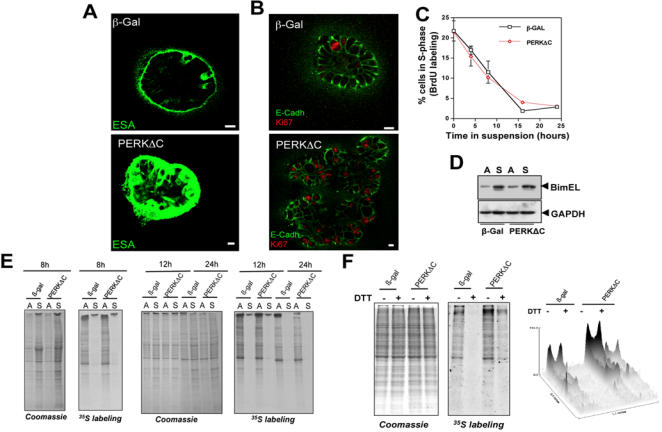
Immunofluorescence for ESA and E-cadherin In β-Gal Control and PERKΔC Acini.(A) Representative confocal images of cross sections through β-Gal and PERKΔC acini immunostained for the cell surface glycoprotein, ESA (epithelial specific antigen, green), on Day 8 in Matrigel. Note the presence of ESA in cells occupying the luminal space of PERKΔC acini (bottom) as compared to proper basolateral localization of ESA in the β-Gal control acini (top). (B) Representative confocal images of β-Gal and PERKΔC acini co-stained for E-cadherin (green) and Ki-67 (red), on Day 8 in Matrigel. Note the presence of strong E-cadherin staining in the cell-cell junctions of luminal cells in PERKΔC acini that also stain positive for Ki-67 while β-Gal control acini show little to no Ki-67 staining in luminal cells and the expected apicolateral staining for E-cadherin in the outer rim of cells. Scale bars = 10 µm. (C) Proliferation assay using BrdU incorporation and flow cytometry to measure the percentage of BrdU-positive β-Gal or PERKΔC cells at different time points in suspension, mean±SD. (D) Immunoblot showing an increase in BimEL levels in suspension but no significant change between β-Gal and PERKΔC cells, GAPDH serves as loading control. (E) Autoradiogram of [35S] Met/Cys incorporation into newly synthesized proteins in β-Gal or PERKΔC cells in full (5%) serum media placed in adhered or suspended growth conditions for 8 hrs, 12 hrs or 24 hrs, showing complete attenuation of protein synthesis in suspension. Coomassie Blue staining of identical gels (left panels) shows protein loading. (F) Autoradiogram of [35S] Met/Cys incorporation into newly synthesized proteins in adhered β-Gal or PERKΔC cells placed in low (1%) serum media, treated with or without DTT (2 mM for 1hr), showing increased protein synthesis in PERKΔC cells. Coomassie Blue staining of an identical gel (left panel) shows equal protein loading. Densitometric analysis and surface plotting of the bands illustrates the increase in intensity in the PERKΔC cells.